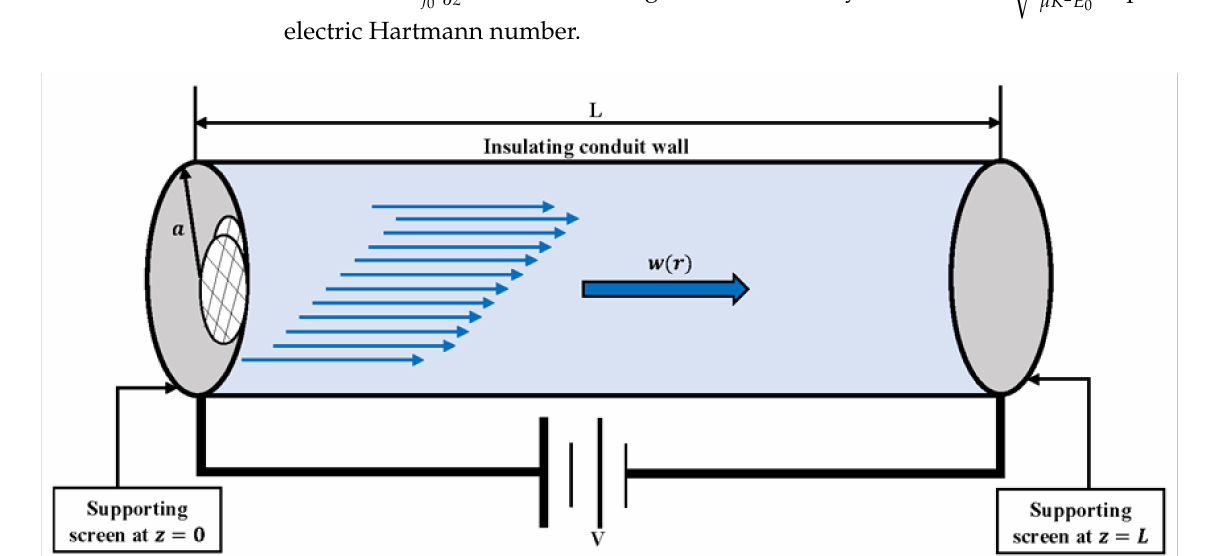
Figure 1. Schematic of the EHD flow in a circular cylindrical